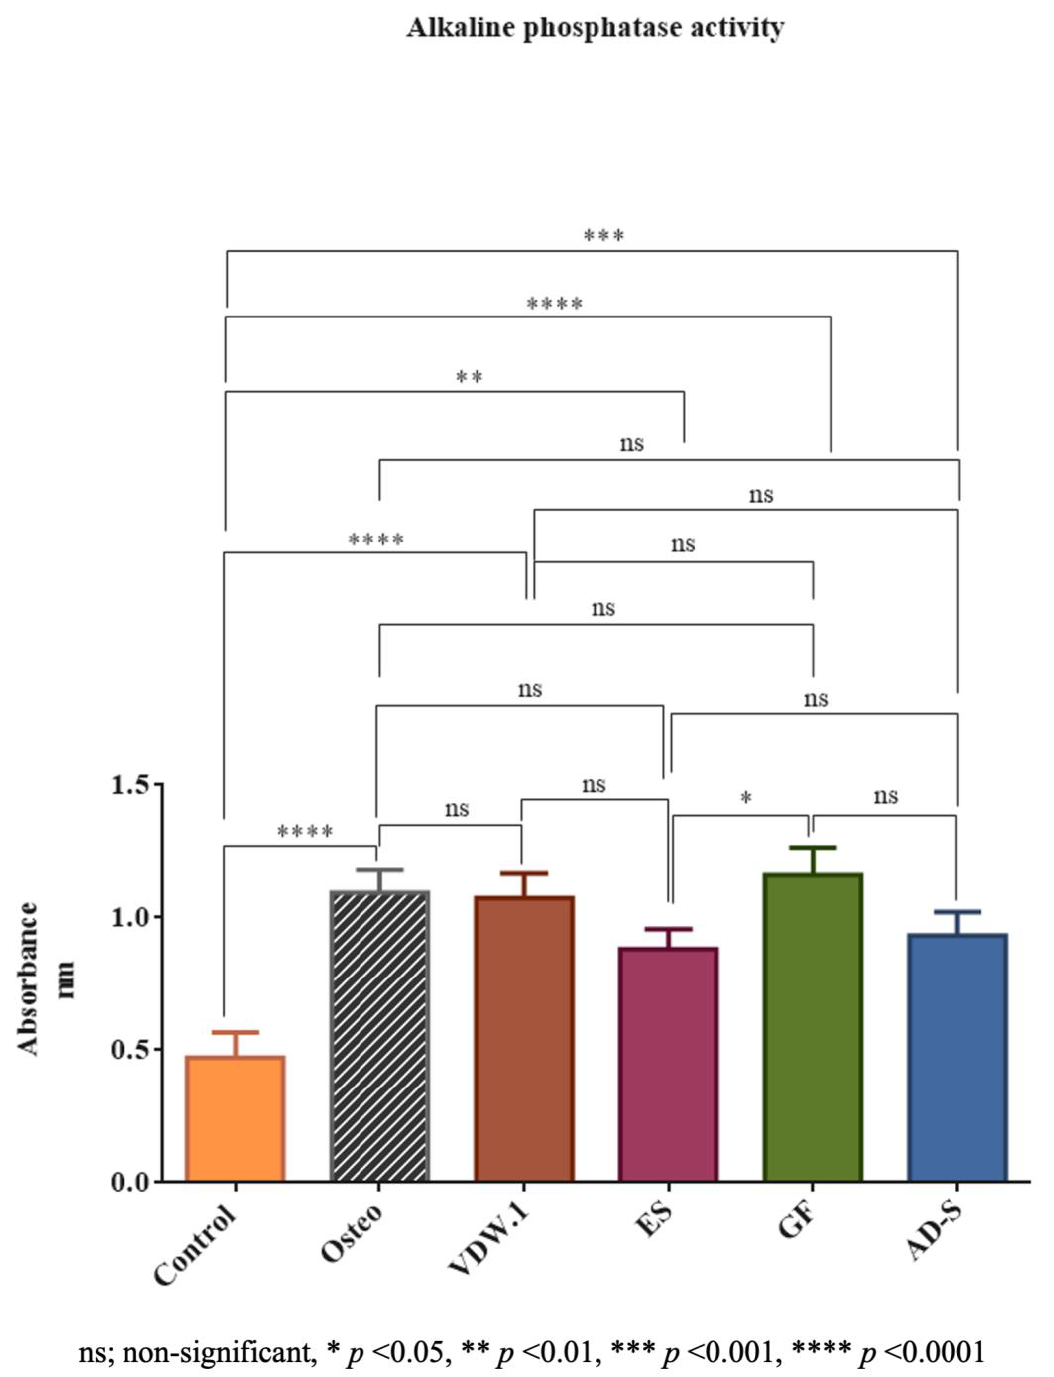
Figure 6. Photometric absorbance of the alkaline phosphatase activity assay. Given are the means with standard deviations. Osteo—osteogenic differentiation media, VDW.1—VDW.1Seal, ES—En- dosequence BC Sealer HiFlow, GF—GuttaFlow-2, AD-S—ADSeal.